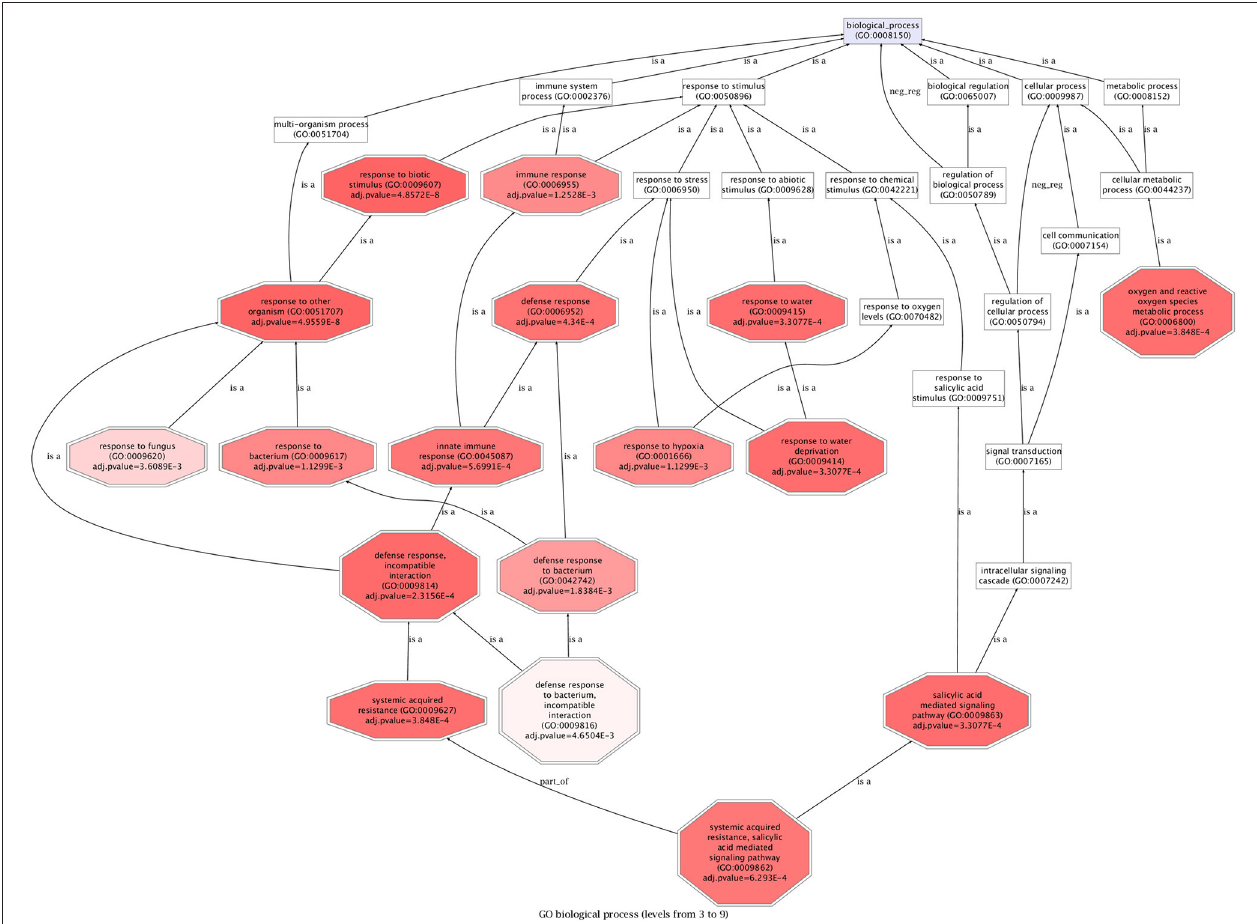
FIGURE 4 | Singular Enrichment Analysis (SEA) on strawberry up-regulated genes. FatiGO was used to extract relevant GO terms for biological processes (BP) at p < 0.005. The terms are considered to be relevant by the application of statistical tests as described in Al-Shahrour et al. (2004). Data are presented as a heat map, as prompts color intensity correlates with adj. p -value, the highest intensity, the lowest adj. p -value. See Table S1 for a detailed list of further genes belonging to overrepresented